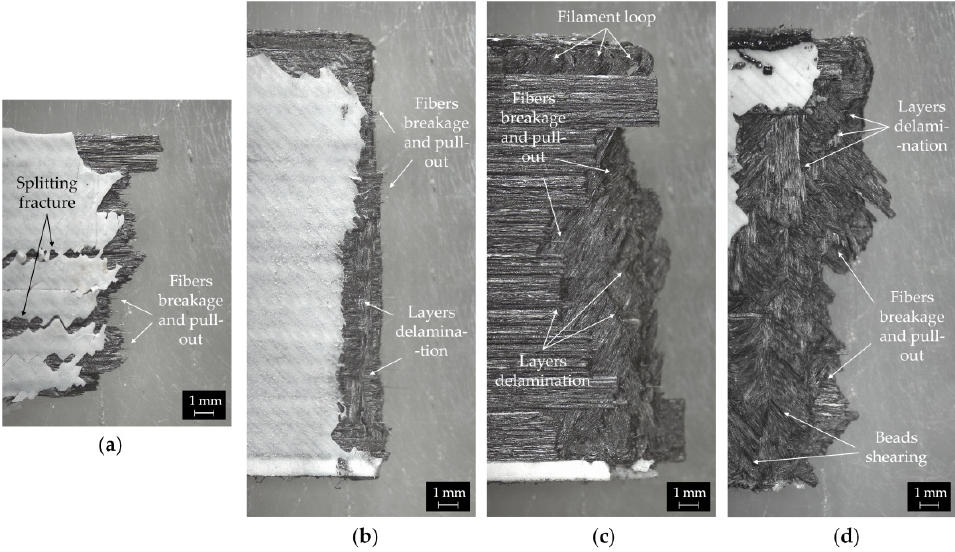
Figure 10. Macroscopic images of the fracture surface of ( a ) [0], ( b ) [0/90] s , ( c ) [0/±60] s and ( d ) [0/45/90/ − 45] s CCF/PA composites. Fiber breakage and pull-out, beads shearing and interlayer delamination are highlighted in the images.